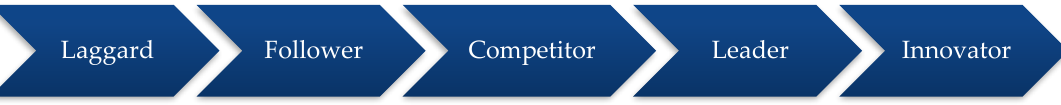
Figure 4. Stages of analytical maturity (Blast Model). Source: own elaboration based on Blast Model.